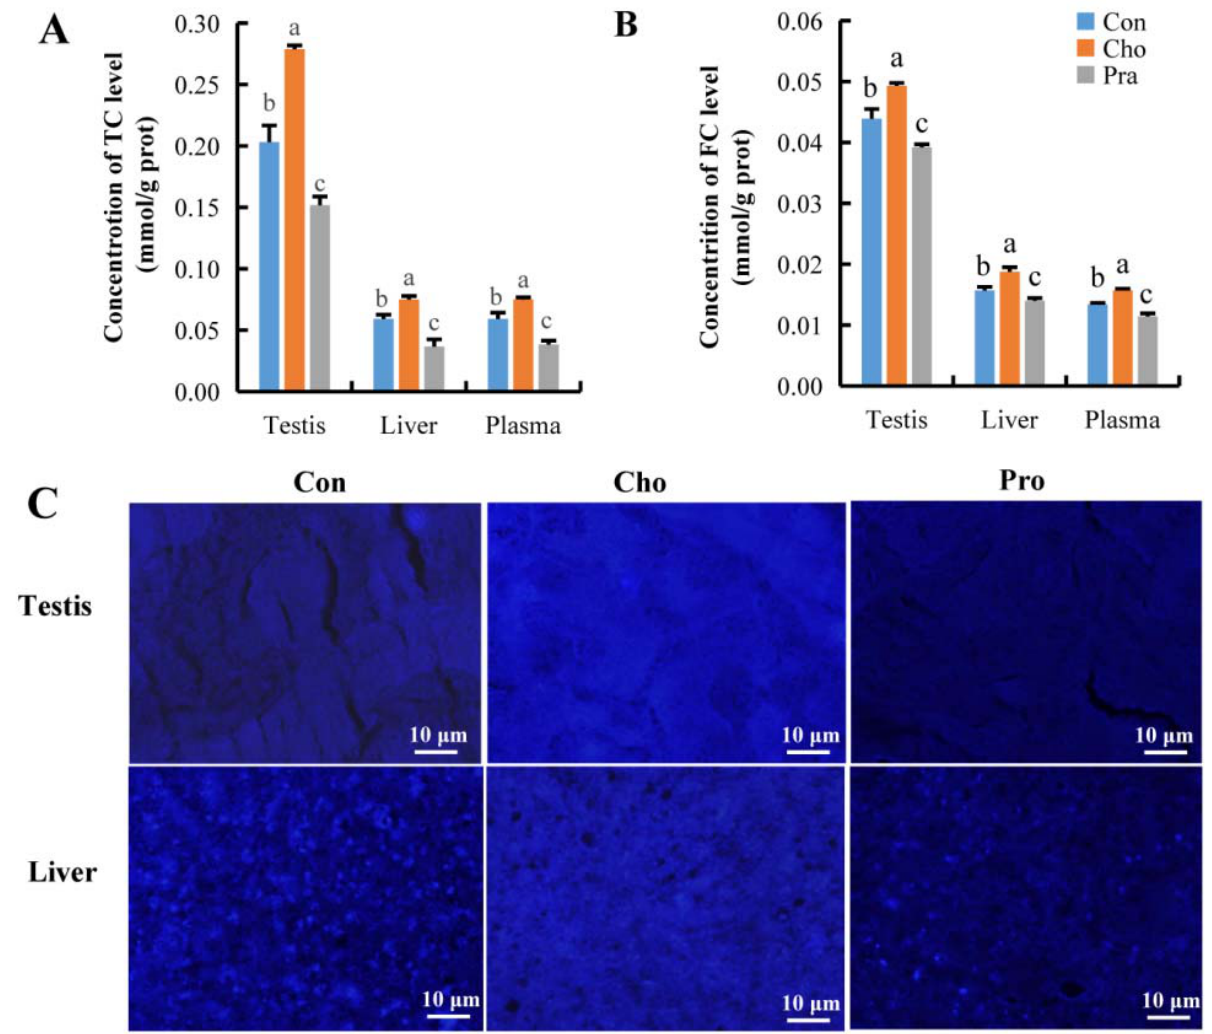
Figure 2. Change in cholesterol level; ( A ) TC; ( B ) FC; ( C ) distribution of FC in testis and liver tissue, blue fluorescence represents FC. All statistical data were expressed as mean ± SD. There is a significant difference between the two groups without the same letter at p < 0.05 level.